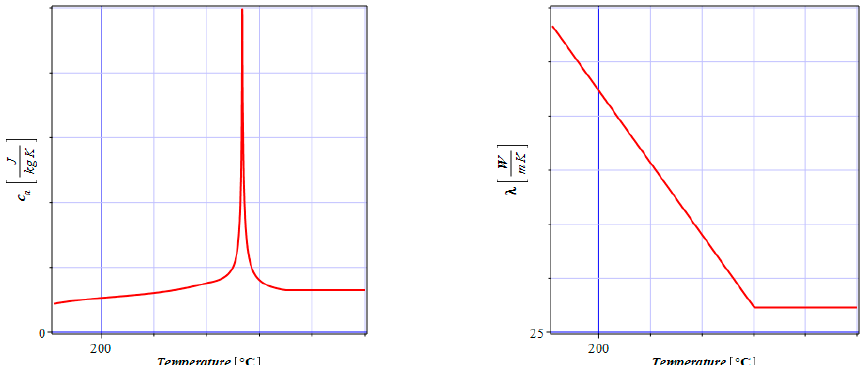
Figure 3. Specific heat (left graph) and heat conductivity (right graph) of temperature variations.